Question: Generate an informative caption for the figure above.
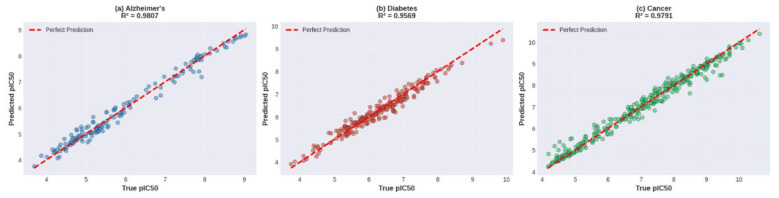
Answer: Predicted vs. true pIC50 scatter plots for (a) Alzheimer's, (b) Diabetes, and (c) Cancer.